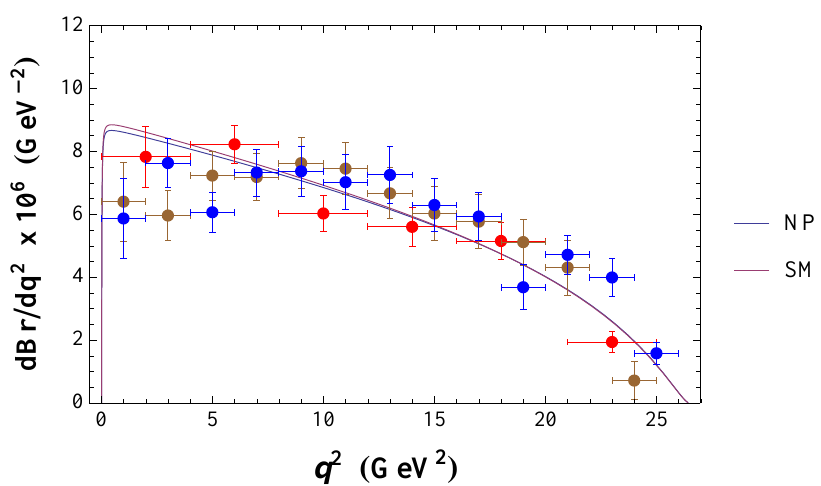
Figure 3. ¯ B → π µ − ¯ ν µ distribution using the form factors in Appendix A and parameters in Table A1, in Standard Model (SM) and in New Physics (NP) at the benchmark point. The red and brown data are from Babar [58,59], the blue ones from Belle Collaboration [57]. The functions I ρ , I ρ , I ρ , I ρ , I ρ and I ρ , which are independent of (cid:101) P , are shown in Figure 4 for 2 s 2 c 3 6 s 1 s 4 SM and NP. The bands are obtained varying the form factor parameters within their estimated ranges. ( q 2 ) , absent in SM. Notice the zero in I ρ 2 s